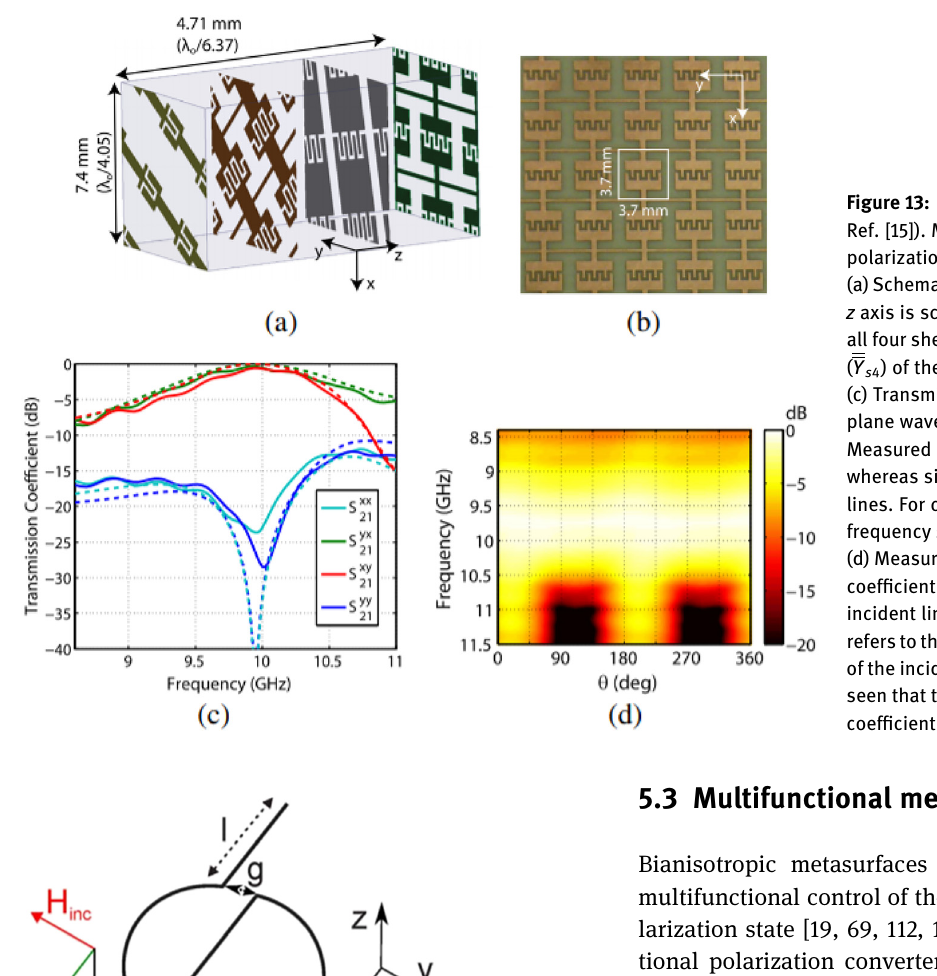
shown. The wire – loop unit cell consists of a Rogers RO3010 substrate with a loaded wire printed on one side and a loaded loop printed on the reverse side. The center of the wire is offset with respect to the center of the loop to create the magnetoelectric response. The re fl ection and trans- mission coef fi cients of the matching layer are shown in Figure 16b. It is observed that the matching layer achieves a minimum re fl ection coef fi cient of − 10 dB over the wide- band of 1 – 22 GHz.